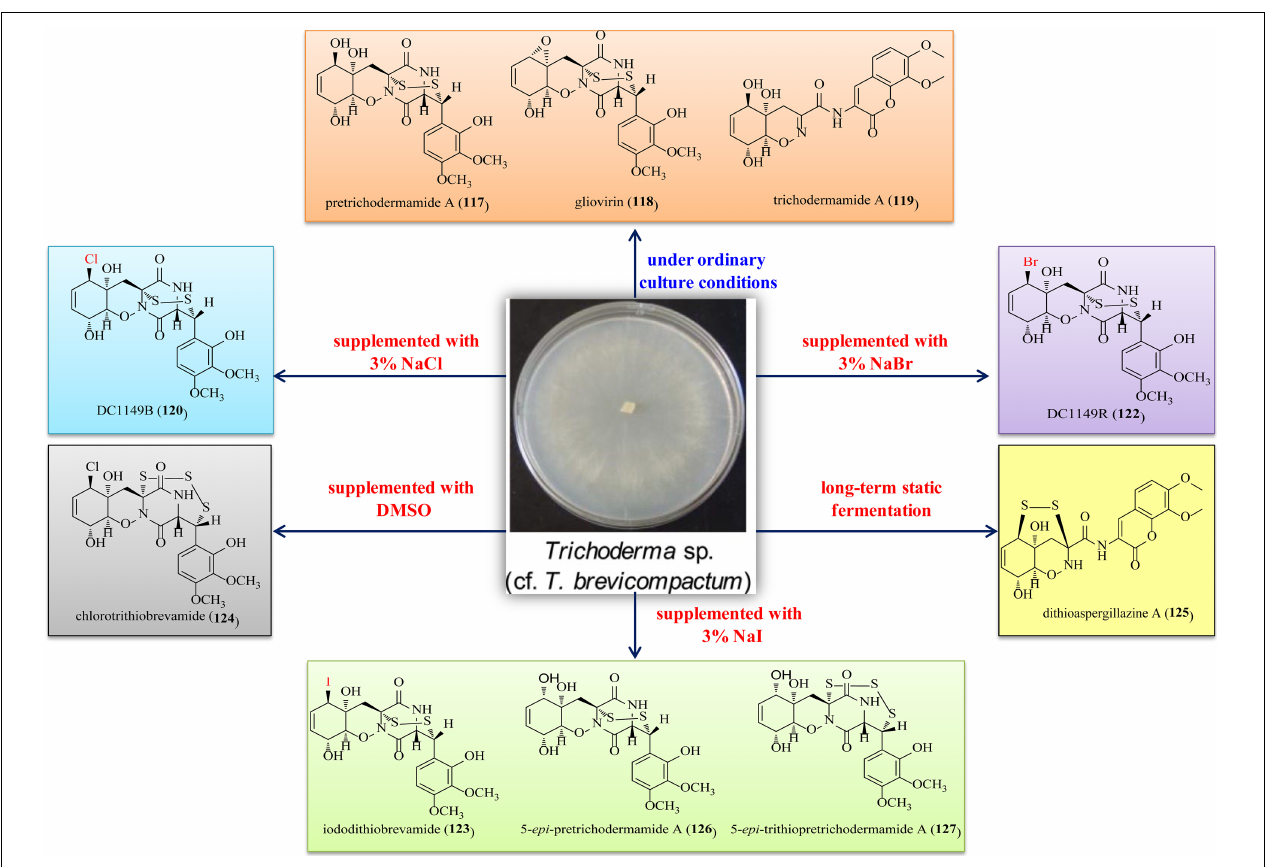
FIGURE 12 | Diketopiperazines produced by Trichoderma sp. TPU199 under different